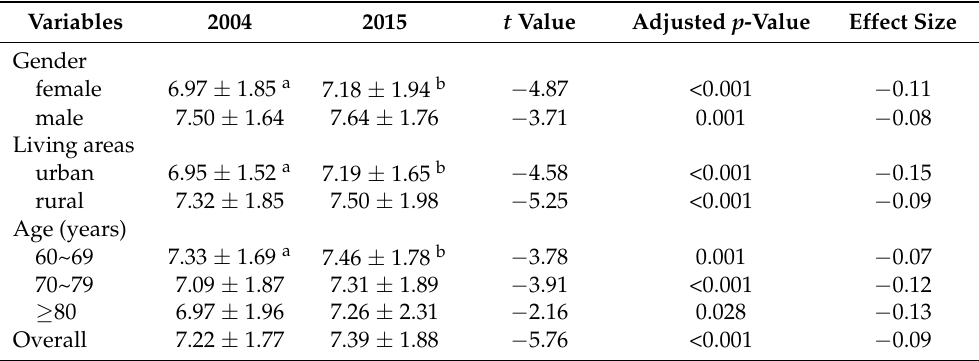
Table 4. Comparison of actual mean sleep duration between different populations aged ≥ 60 years in Shandong province in 2004 and 2015 (h, mean ± SD